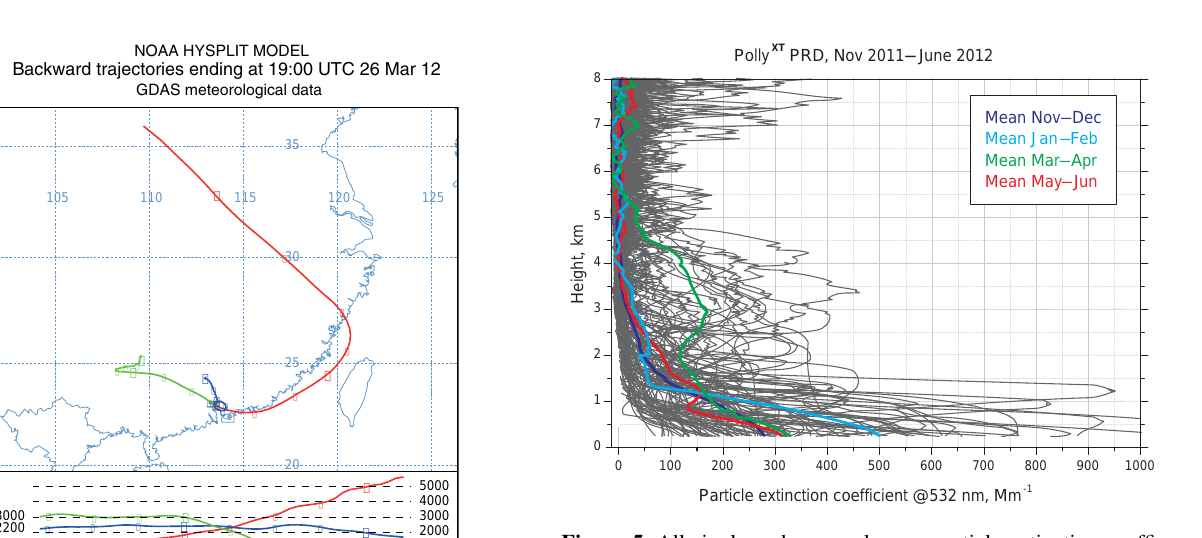
Figure 5. All single and seasonal mean particle extinction coeffi- cient profiles measured by the lidar at 532nm during the entire ob- servation period from November 2011 to June 2012. tween 2 and 4.5 km height, with particle extinction coeffi- cients of up to 170 Mm − 1 at 2.9 km height. This is more than 4 times the values for the three other mean profiles. In total, the mean March–April profile reached zero values at 5.5 km, the largest layer top height out of the four seasonal mean pro- files. The largest mean particle extinction coefficient value in the PBL was 330 Mm − 1